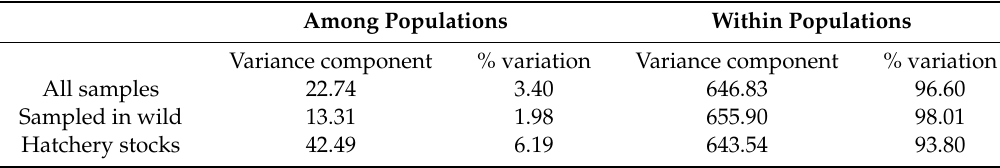
Table 2. Analysis of Molecular Variance (AMOVA) applying the F ST estimator of Weir and Cockerham [53] variance component, calculated for 3 scenarios: all samples, specimens sampled from wild, and only hatchery stocks.